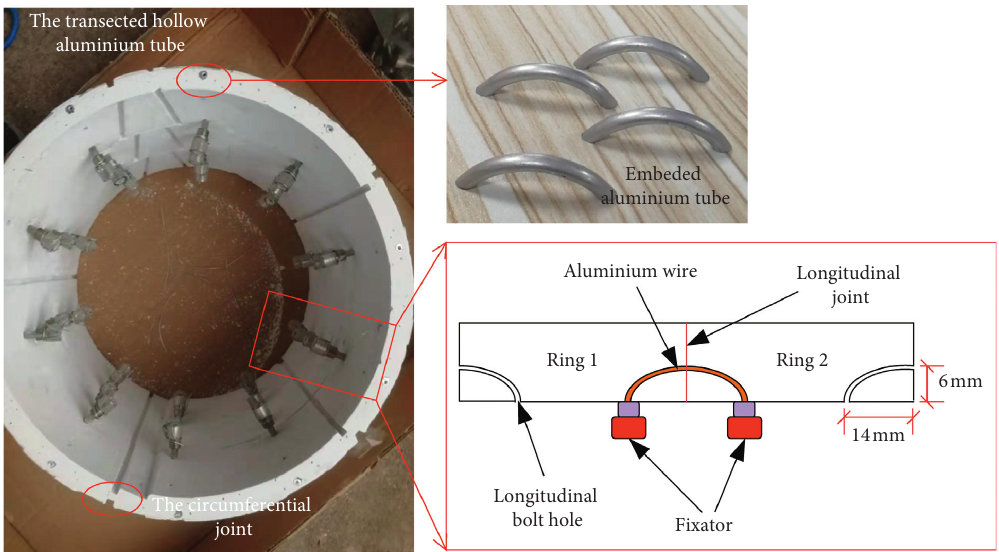
Figure 9: The details of the longitudinal joints.